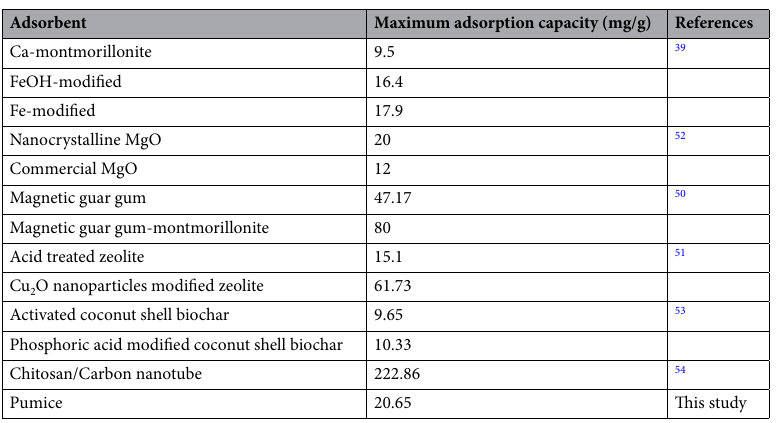
Table 1. Comparison of diazinon adsorption efficiency of different